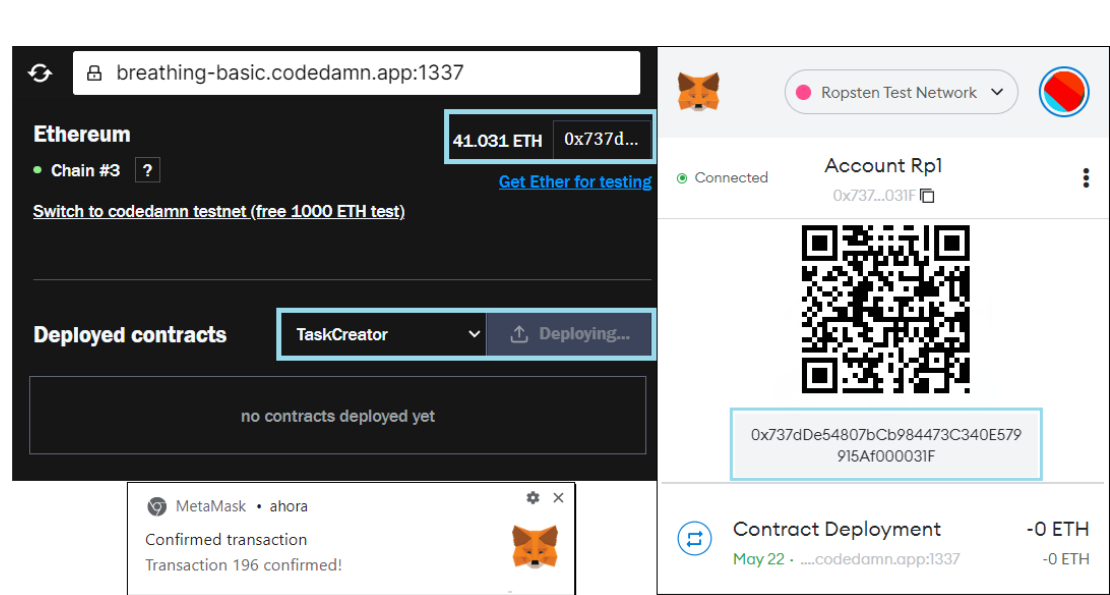
Figure 4: Smart contract deploying on web platform